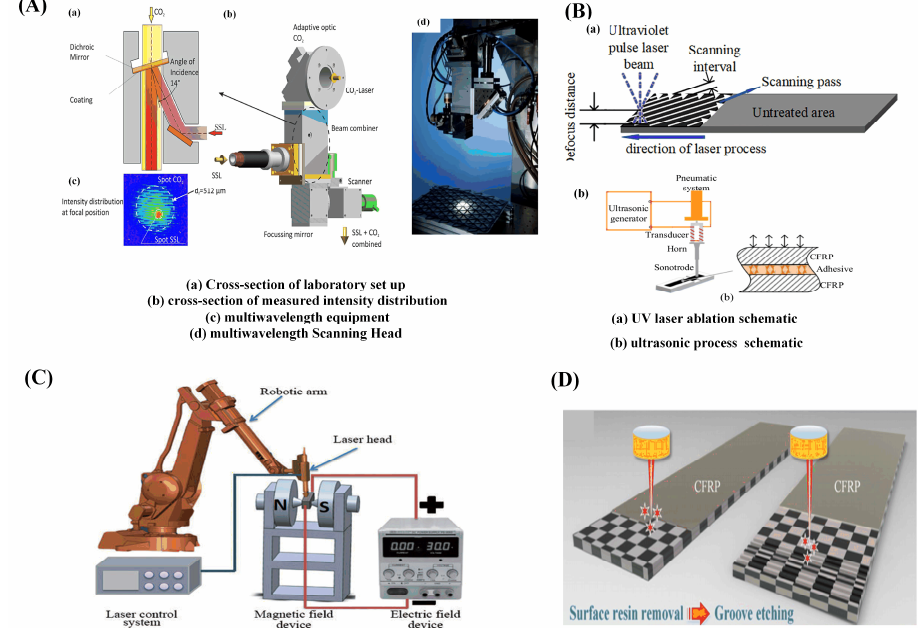
Figure 17. Schematic diagram of the new processing method of laser processing: ( A ) schematic diagram of dual-wavelength combined laser [112]; ( B ) the schematic diagram of the two-step laser surface treatment of a CFRP laminate [118]; ( C ) schematic of electromagnetic-field-assisted laser groove processing device [117]; ( D ) ultrasonic and laser process schematic [116].